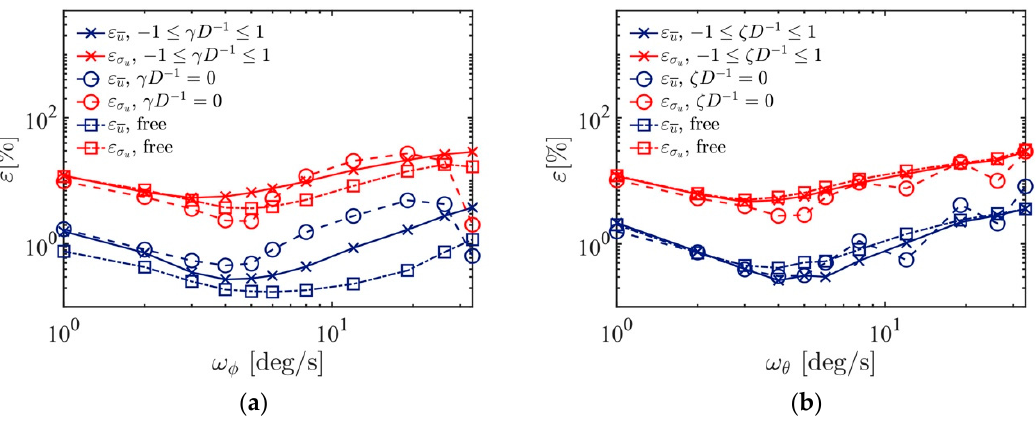
Figure 9. Velocity error ( ε u , blue) and standard-deviation error ( ε σ compared against the LES for the planar section (crosses), centreline (circles), and free-flow region (squares) of ( a ) PPI scans and ( b ) RHI scans.